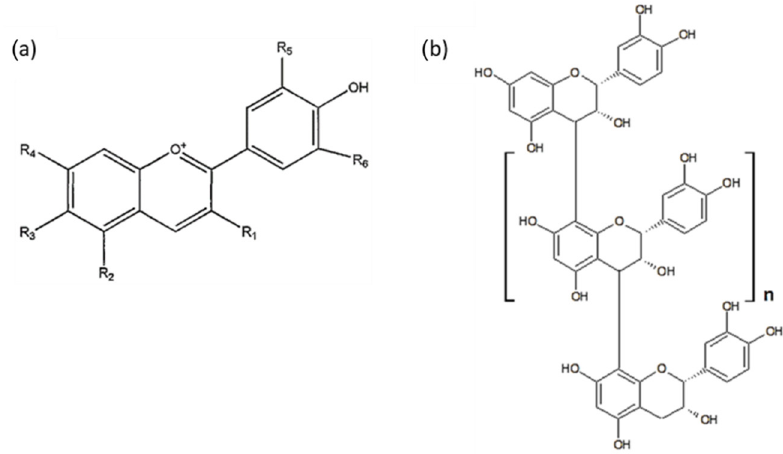
Figure 11. Schematic structure of individual anthocyanins ( a ) and proanthocyanidins (PACs) ( b ) [42,43]. CEM Type-II and CJMC-5 aliphatic membranes did not enter π - π (stacking) interac- tions with anthocyanins and PACs. This was why these membranes adsorbed less poly- phenols and especially PACs, which had no electrical charge. At the same time, the amount of anthocyanins adsorbed due to electrostatic interactions increased in the same sequence as the ion exchange capacity of the gel phase: CJMC-5 < CEM Type-II (Table 4). Therefore, CJMC-5 contribution to the adsorption of anthocyanins due to electrostatic in- teractions was minimal. Even though CEM Type-II membrane had fewer macropores compared to the CJMC-5 membrane, the number of macropores seemed to be enough to provide desorption of a significant amount of anthocyanins during CEM Type-II mem- brane treatment with a mixture of solvents. As a result, a lower quantity of anthocyanins was desorbed from the CJMC-5 membrane, which had a higher number of macropores, but the lowest gel phase ion-exchange capacity (Table 4). It is important to mention at this step that the breakage of electrostatic interactions was achieved only if the anthocyanins, in cationic forms in acidic cranberry juice, became neutral molecules (no interaction with the fixed groups of the membrane) or turned into anions (the charge coincides with the charge of fixed groups and leads to electrostatic repulsion). pH value at which these transformations take place depending on the struc-